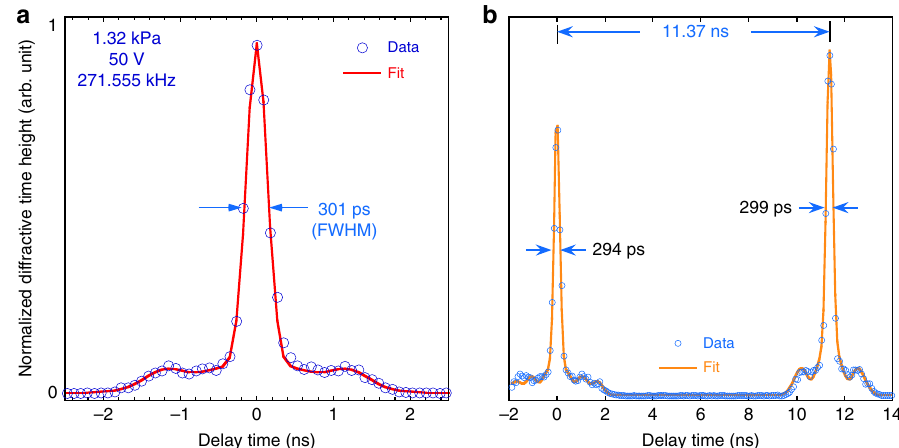
Fig. 5 Demonstration of 300-ps diffractive time window. a Delay scan of a single X-ray pulse showing a 301-ps DTW. b Time-delay scan covering two consecutive pulses in the Advanced Photon Source 324-bunch mode when the two X-ray pulses are 11.37 ns apart. The scan clearly demonstrates DTW widths of 300 ps over the 16-ns delay time, measured in a time span of ca. 235